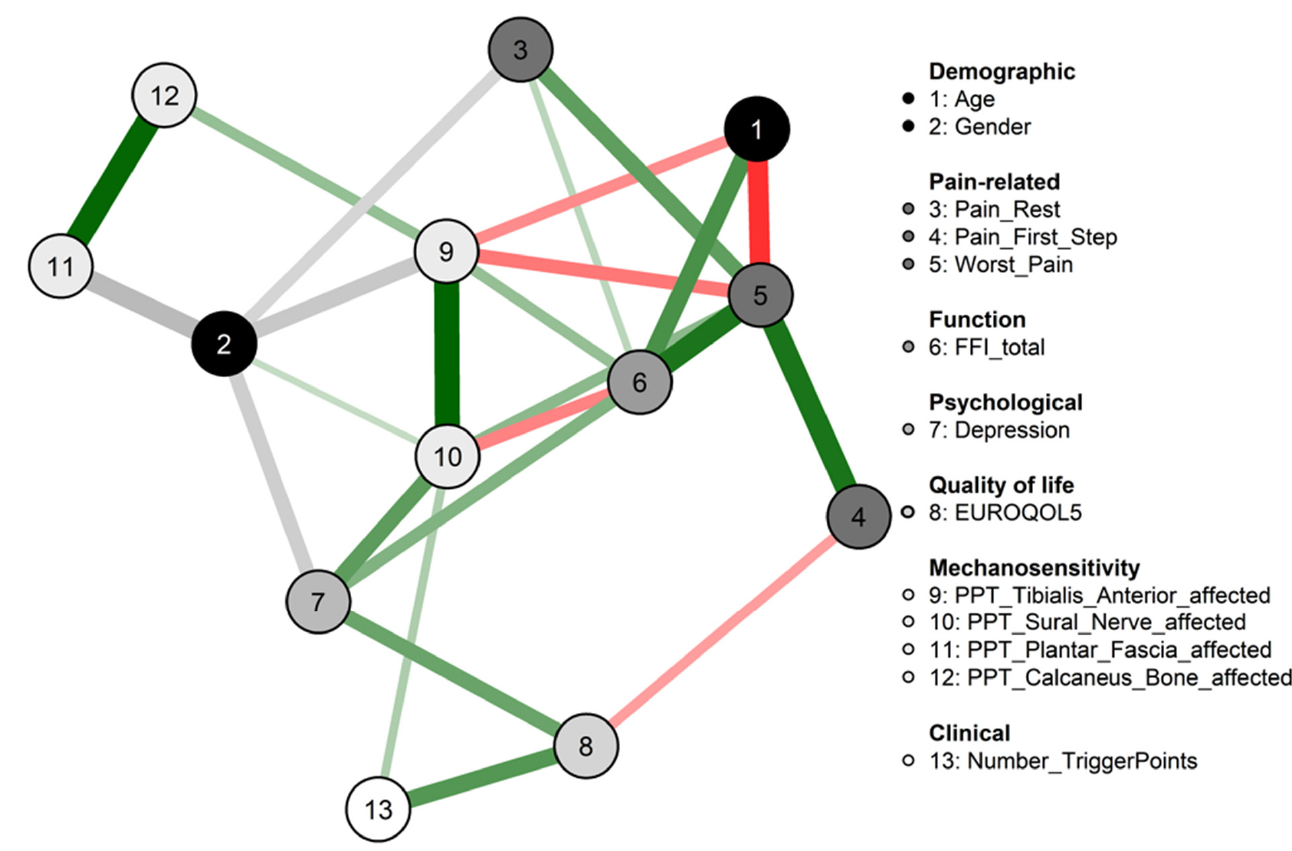
Figure 1. Network analysis of the association between demographic, pain-related, function, psycho- logical, quality of life, and clinical presentation in patients with unilateral chronic heel pain. Edges represent connections between two nodes and are interpreted as the existence of an association between two nodes, adjusted for all other nodes. Each edge in the network represents either positive regularized adjusted associations (green edges) or negative regularized adjusted associations (red edges). The thickness and color saturation of an edge denotes its weight (the strength of the associa- tion between two nodes). Abbreviatures: FFI, Foot Function Index; PPT, Pain Pressure Threshold. Centrality indices are shown in Figure 2. The worst pain intensity (node 5) was the node with higher strength centrality, followed by PPT at tibialis anterior (node 9) and foot function (node 10). Regarding the closeness centrality, PPT at tibialis anterior (node 9) and sural nerve locations (node 10), depression (node 7) and worst pain intensity (node 5) were the highlighted nodes. Finally, PPT at the tibialis anterior (node 9), worst pain intensity (node 5), and gender (node 2) were the nodes showing the greatest betweenness centrality. The betweenness and closeness measures of the network were unstable at CS cor=0.7 = 0.00 and CS cor=0.7 = 0.00, respectively. However, the strength centrality measure was found to be relatively stable with CS cor=0.7 = 0.05 (Figure